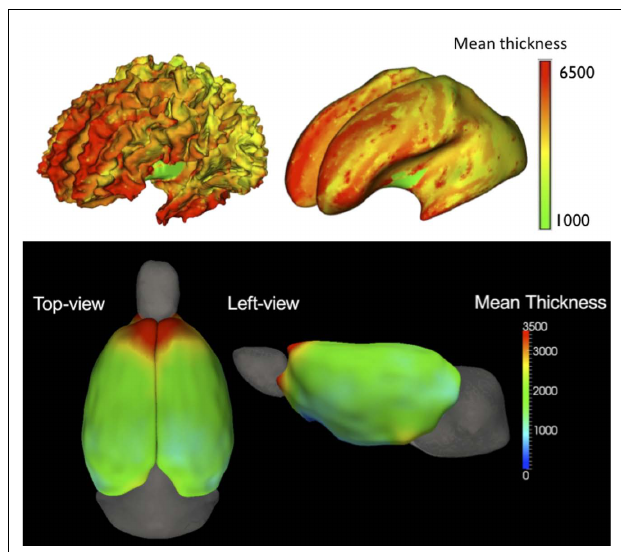
FIGURE 5 | Mean cortical thickness (in μ m) in a human 2year old population (top, seen on the original white matter surface and the corresponding inflated brain surface;Vachet et al., 2011) and an adolescent rat population (bottom, seen from two viewpoints; Lee et al.,